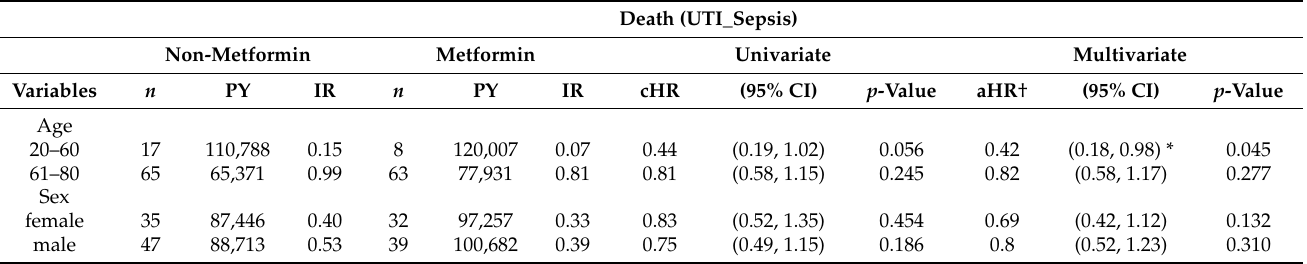
Table 3. Risk of death due to UTI or sepsis in metformin users vs. nonusers in patients with T2DM stratified by age and sex.